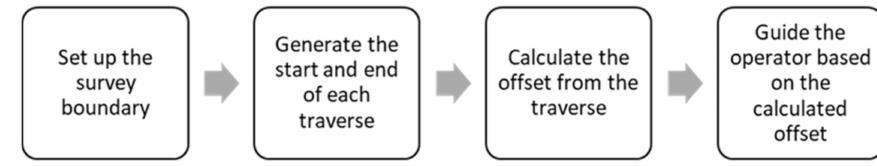
Figure 1. General workflow of the guidance